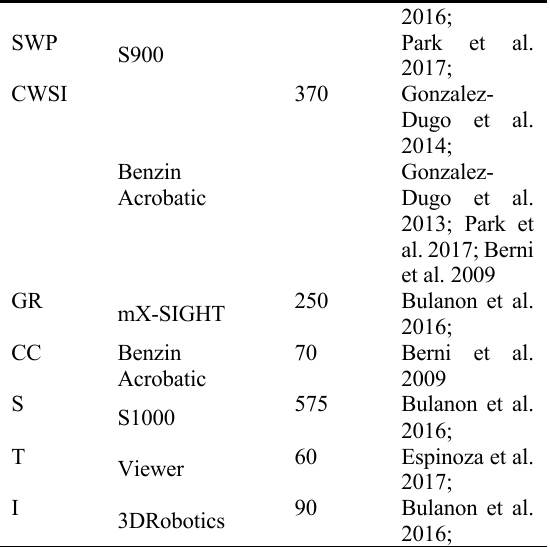
Table 3 - UAVs platforms and data collected altitude applied